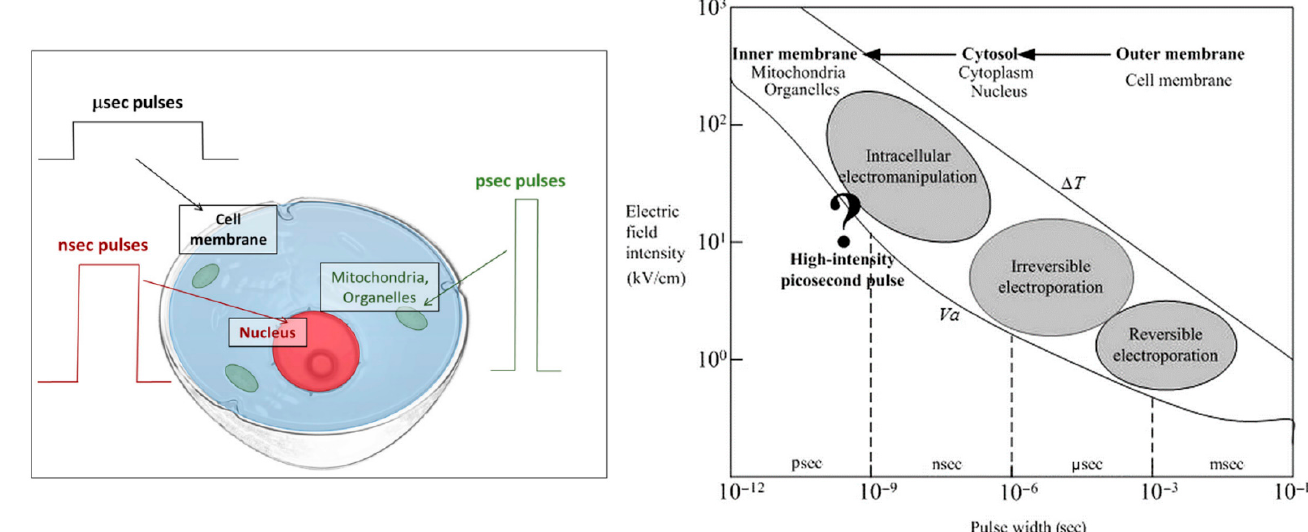
Figure 5. The biological effects of electric field pulses as a function of the pulse length and magnitude, with ( left ) the cellular structures preferentially affected by each type of pulse and ( right ) the resulting biological mechanisms. ( left ) Reprinted from [162] with permission from Elsevier, based on [165]. ( right ) Reprinted from [166] with permission granted from the editor.